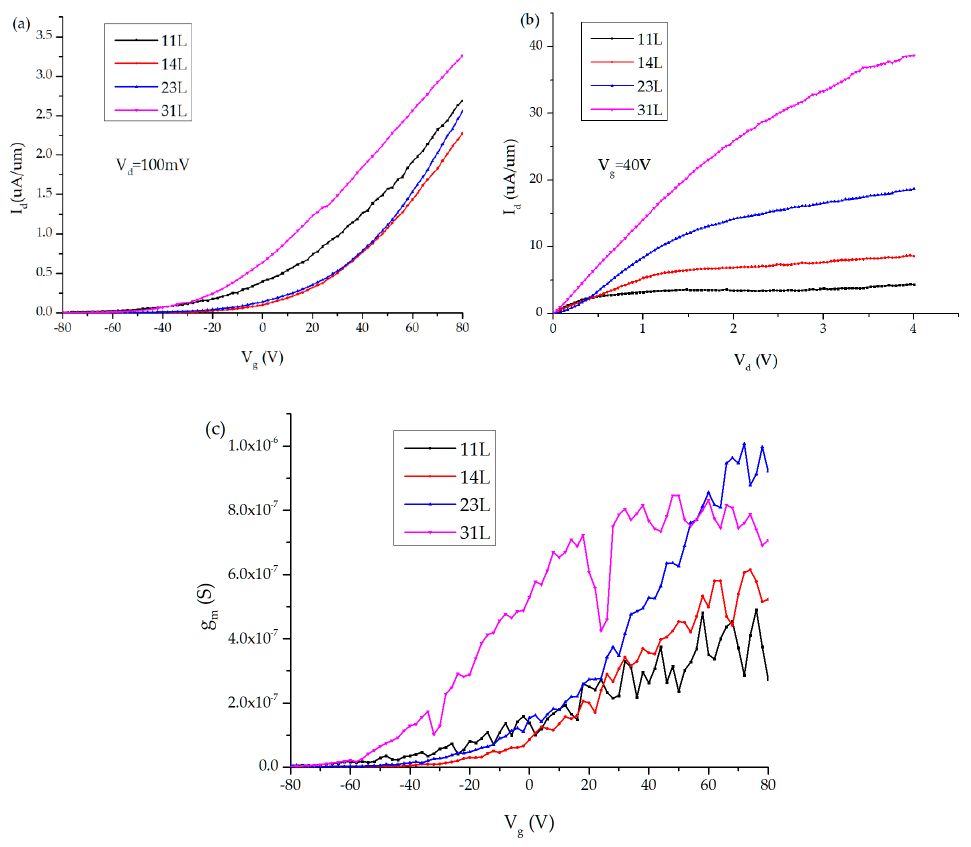
Figure 5. ( a ) I d - V g curves of 11 L, 14 L, 23 L, 31 L MoS 2 FET; ( b ) I d - V d curves of 11 L, 14 L, 23 L, 31 L MoS 2 FET; ( c ) g m -V g curves of 11 L, 14 L, 23 L, 31 L MoS 2 FET.